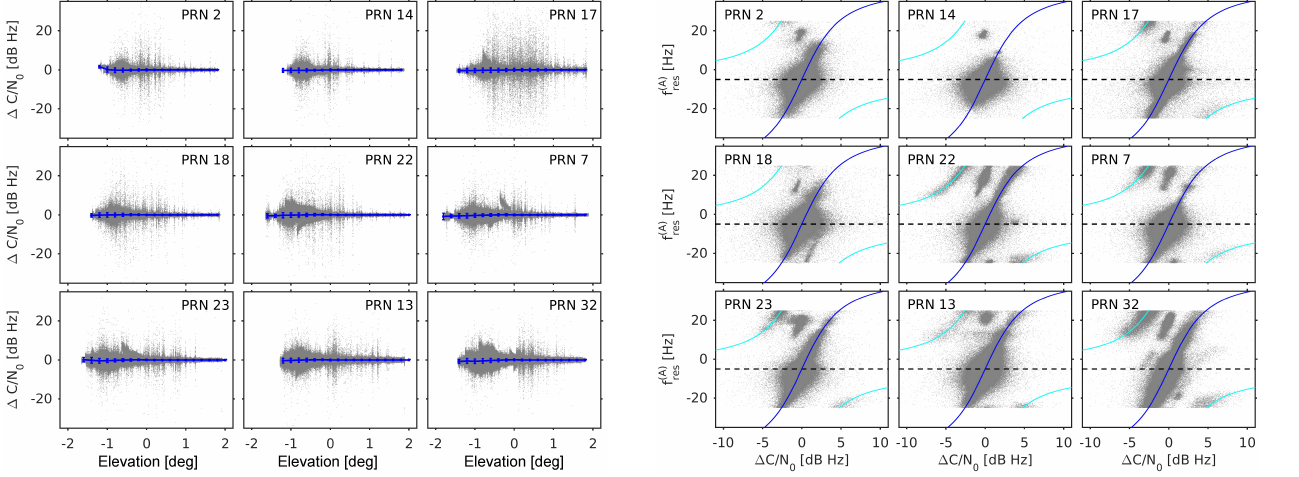
Figure 12. Same as Fig. 9, however, showing the residual frequency in O/L channel A as a function of (cid:49)C /N 0 , the difference of the two O/L density ratios (gray points). The theoretically expected result (Eq. 16) is shown in dark blue; light blue lines are the theoretical result shifted by ± 50Hz highlighting the occurrence of frequency aliasing. The horizontal dashed lines mark the − 5Hz residual fre-